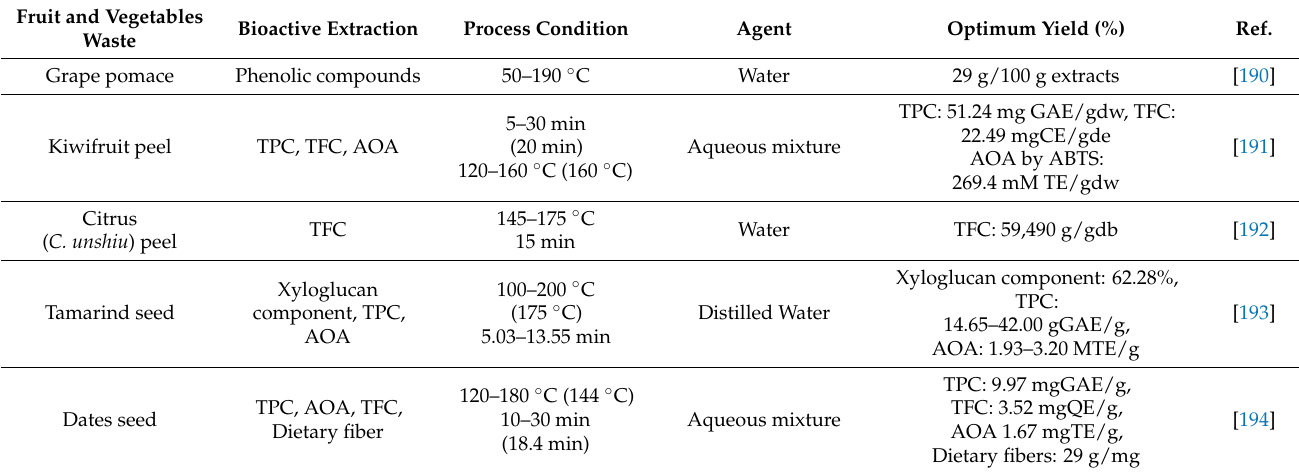
Table 8. Progress studies of FVW involving sub-critical water